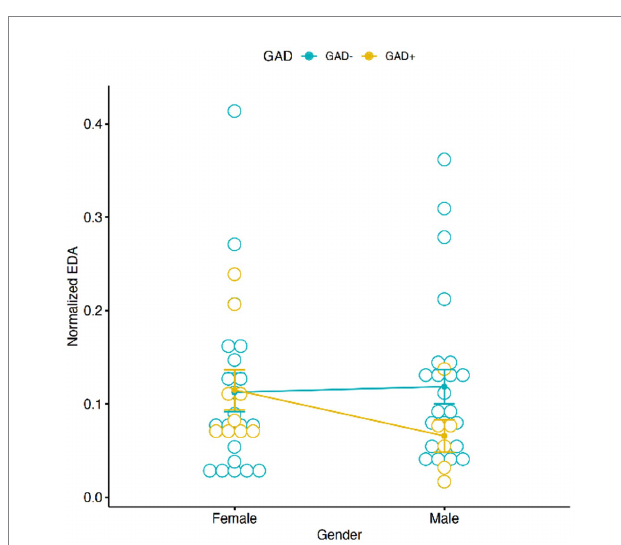
FIGURE 2 Graphic distribution of normalized EDA according to GAD ± and Gender. No significant interaction was found between Gender, EDA and GAD ±.